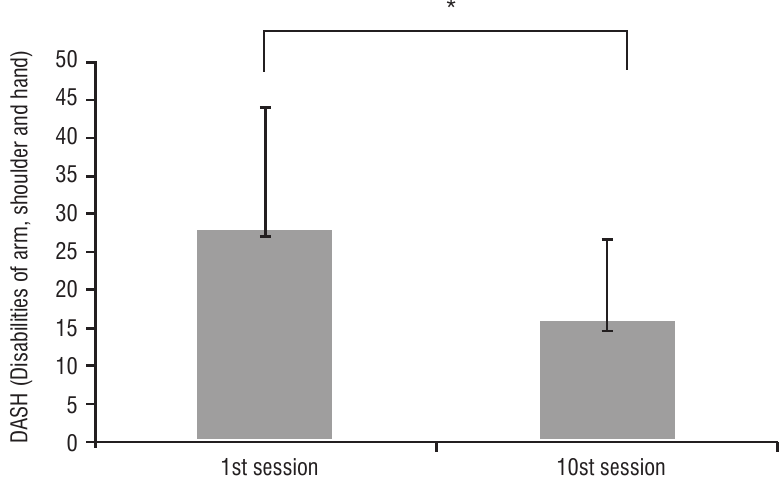
surgery (Figure 1).